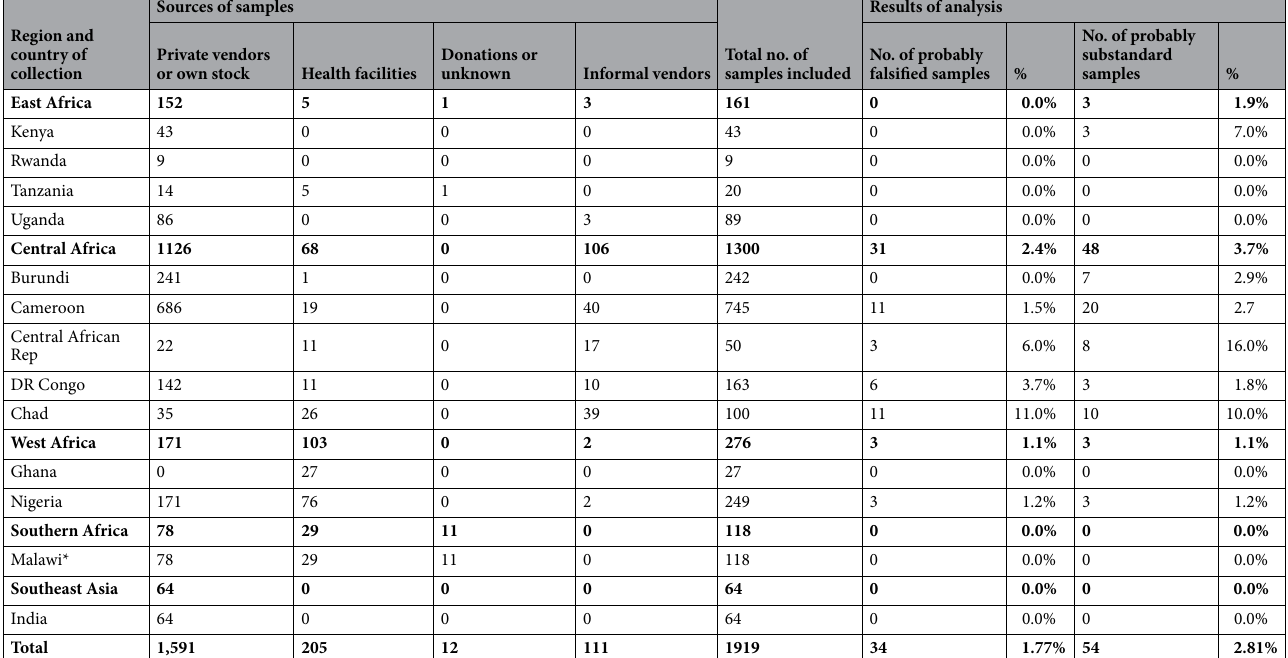
Table 1. Overview of collected medicine samples, and results of analysis. Three faith-based drug supply organizations in Cameroon contributed to this study, and two in the Democratic Republic of the Congo (DRC). *For two samples from Malawi, the source is unknown.